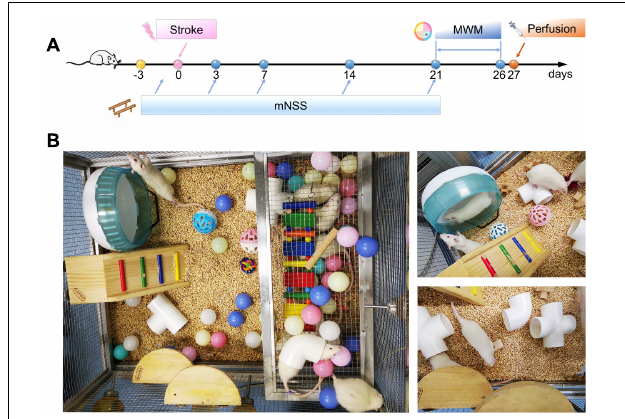
FIGURE 1 | Flow chart of the experimental protocol and enrichment settings. (A) Timeline of behavioral testing after stroke. Modified Neurological Severity Scores (mNSS) were tested 3, 7, 14, and 21 days post-stroke (arrows) and compared with baseline performances to evaluate sensorimotor deficits. Morris Water Maze (MWM) test was performed from day 21 to day 26 post-stroke to evaluate spatial learning and memory. (B) The setting of an enriched